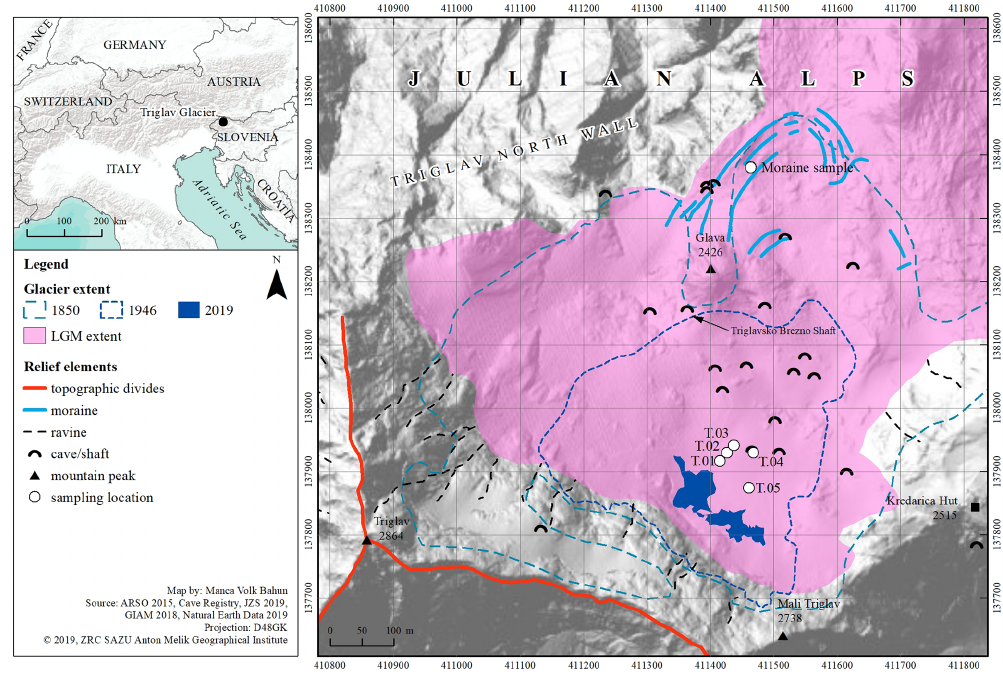
Figure 2. Locality map of the Triglav Glacier, the sampling sites discussed in the text and general geomorphology.